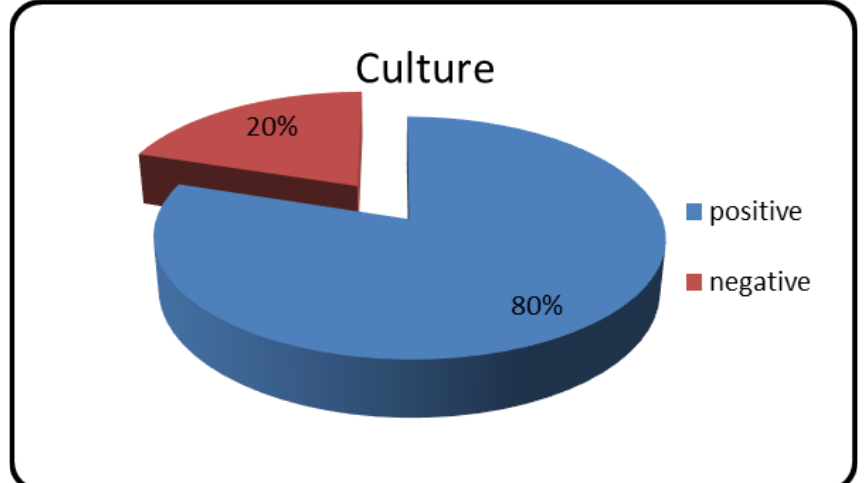
Figure 6. Culture positivity in the corneal scraping